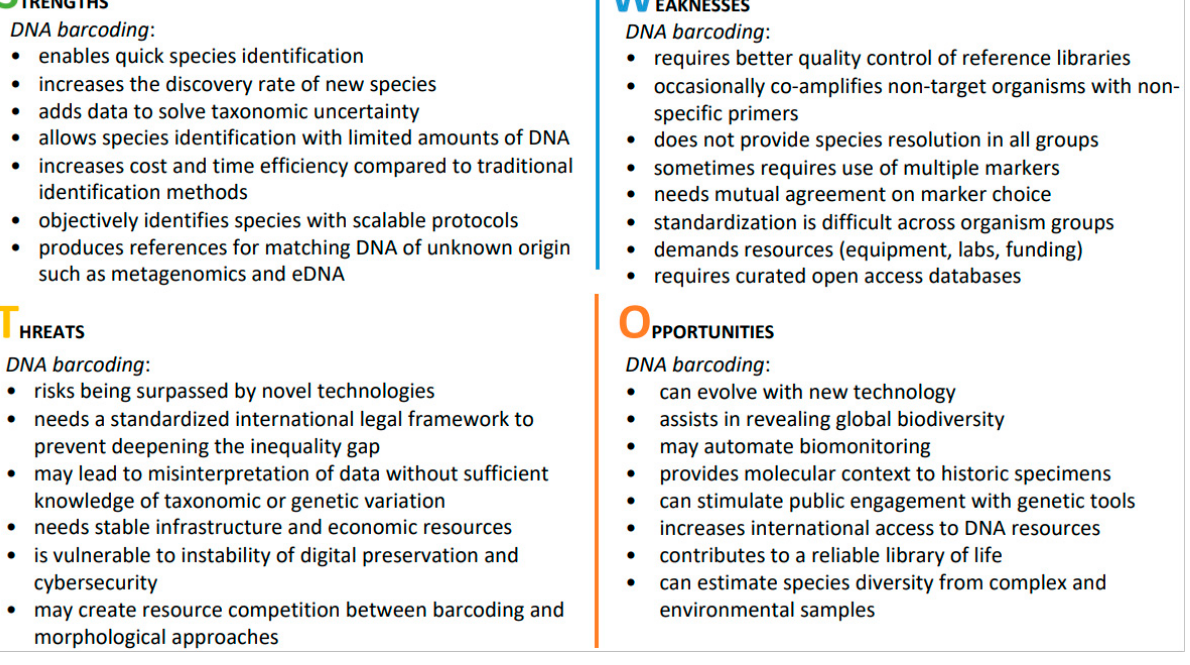
Figure 3. Major strengths, weaknesses, opportunities, and threats for DNA barcoding, resulting from the SWOT analysis.